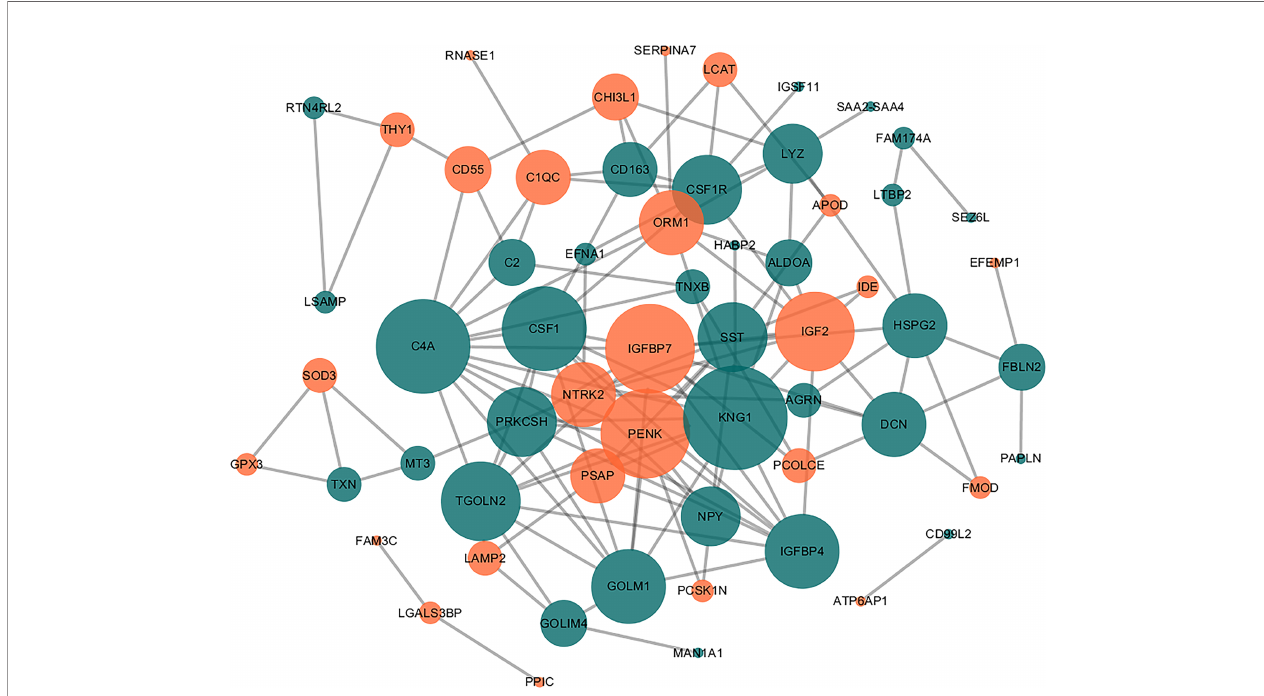
FIGURE 3 | Direct PPI network. Sixty of the 83 DEPs were predicted to participate in direct PPIs, and the interactions were based on the ‘ evidence ’ mode and a moderate level of con fi dence. Nodes represent proteins and edges represent PPIs. The degree determines the node size, where orange represents upregulated and blue represents